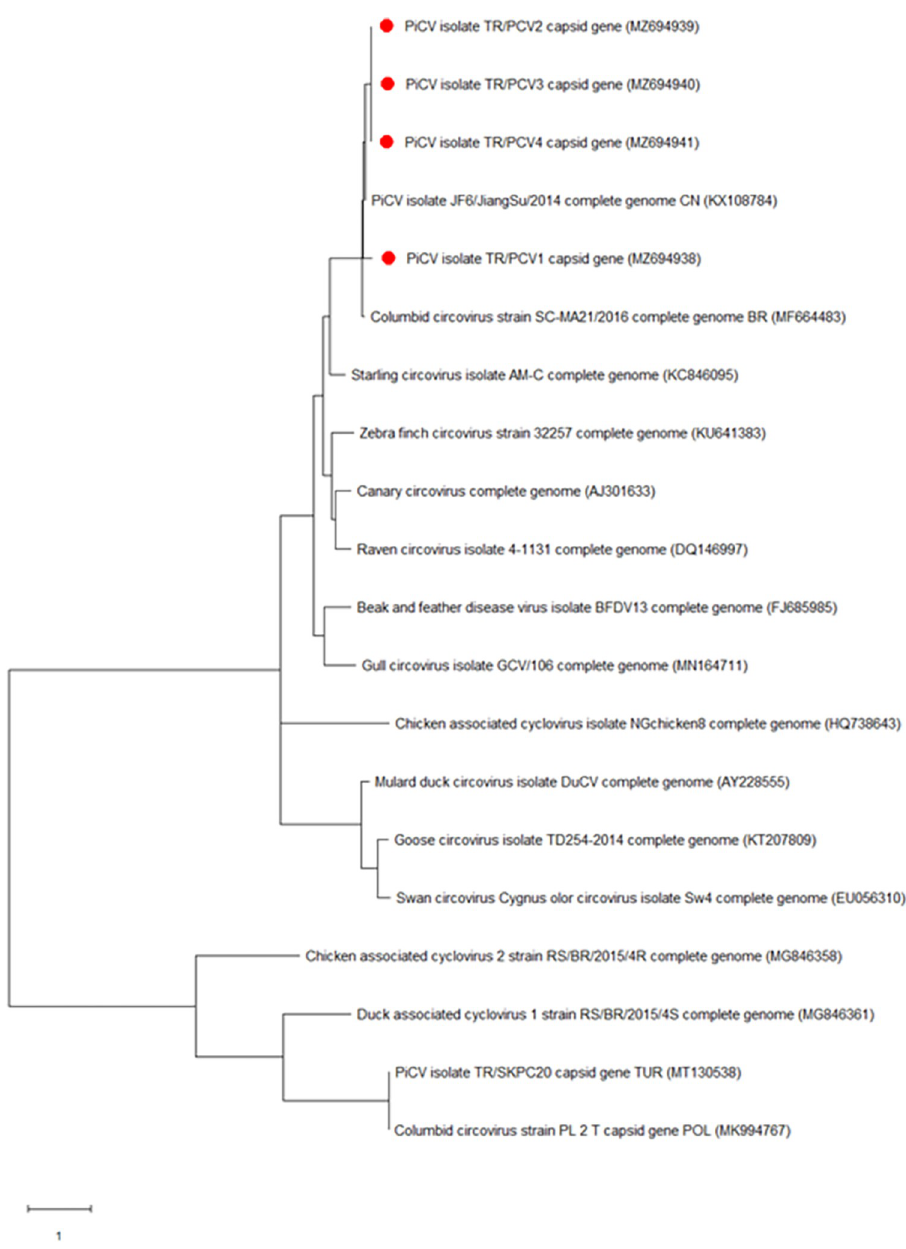
Fig 1. Phylogenetic tree based on the partial nucleotide sequence of the PiCV capsid gene (325 bp). The tree shows circovirus species which affect fowl. The tree shows the names and GenBank accession numbers of each isolate. The PiCV isolates from this study are indicated by a red